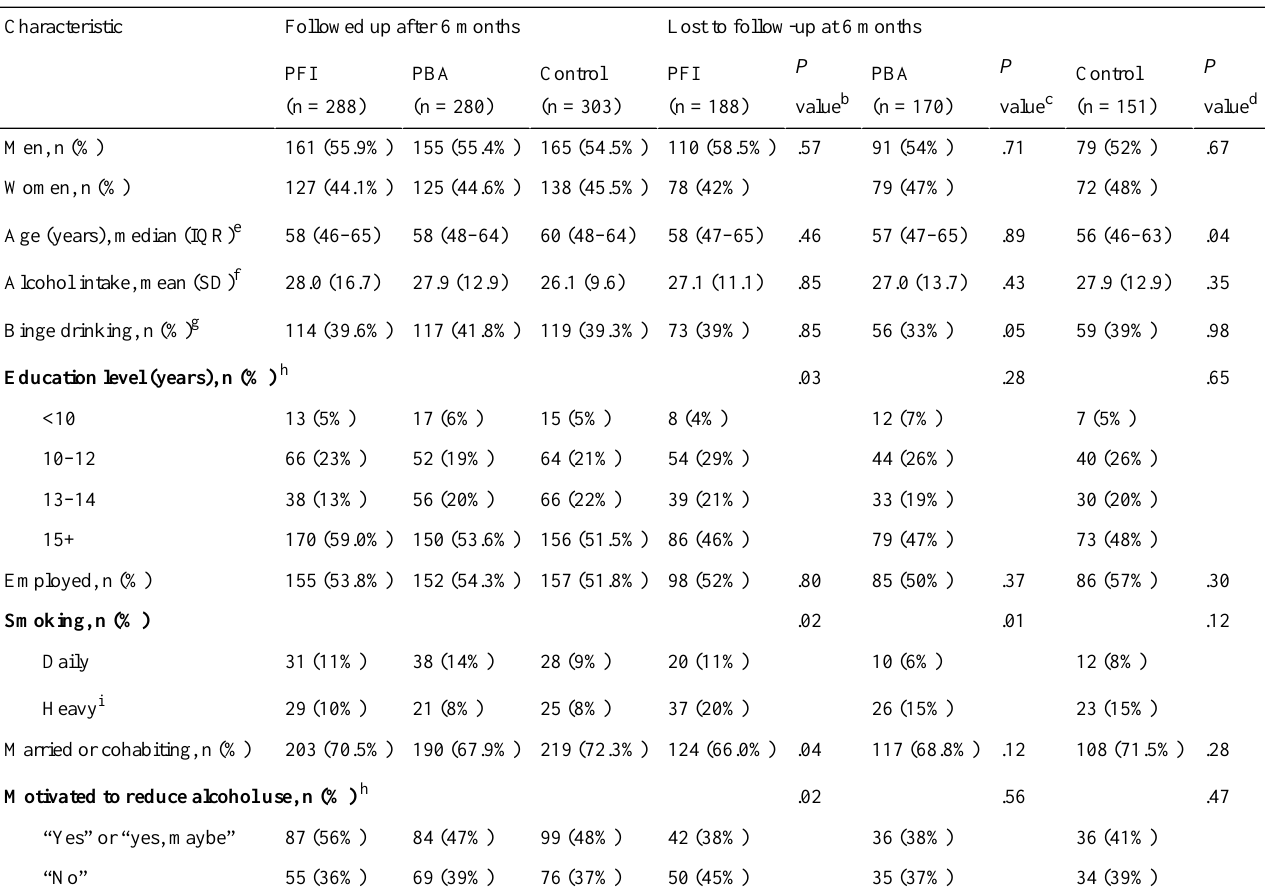
Table 2. Comparison of characteristics of participants randomly assigned to Internet-based brief personalized feedback intervention (PFI), Internet-based personalized brief advice intervention (PBA), or control group at baseline between those followed up after 6 months and those lost at 6-month follow-up. a Lost to follow-up at 6 monthsFollowed up after 6 monthsCharacteristic